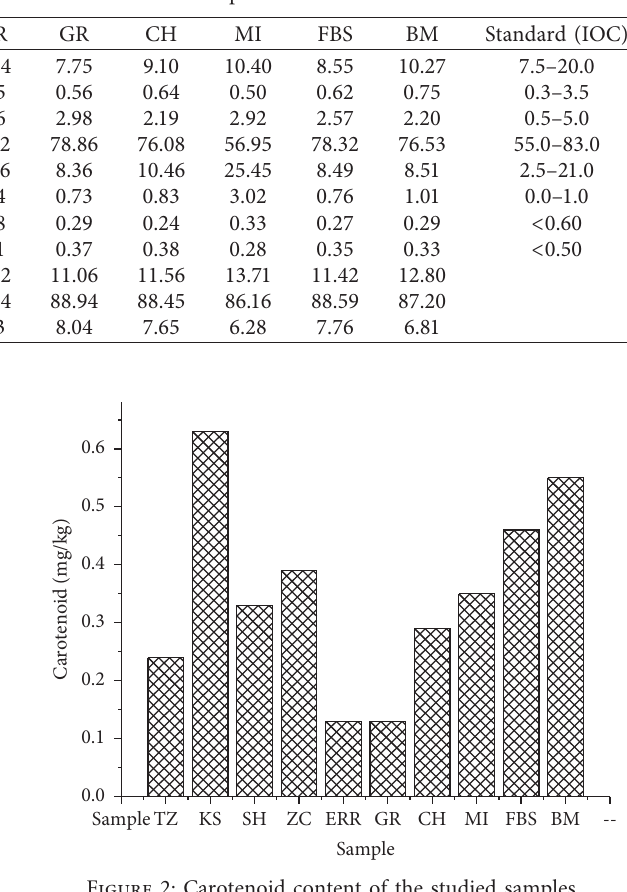
Table 3: Fatty acid composition of the studied samples.